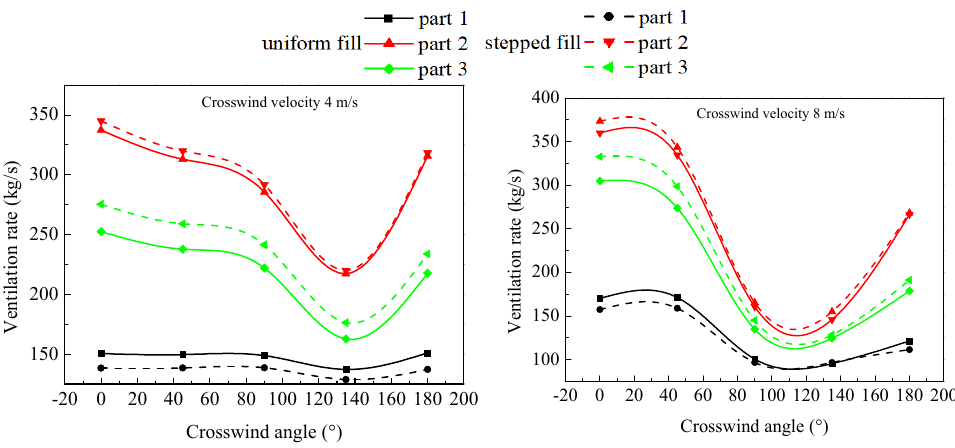
Figure 7. The variation of ventilation rate in different parts. Figure 8 indicates the air density difference at the eliminator top ( ρ n for the stepped fill, ρ u for the uniform fill). The pumping force of the SIDCT is mainly from the fan, and the proportion of the pumping force causing the density difference of moist air is very